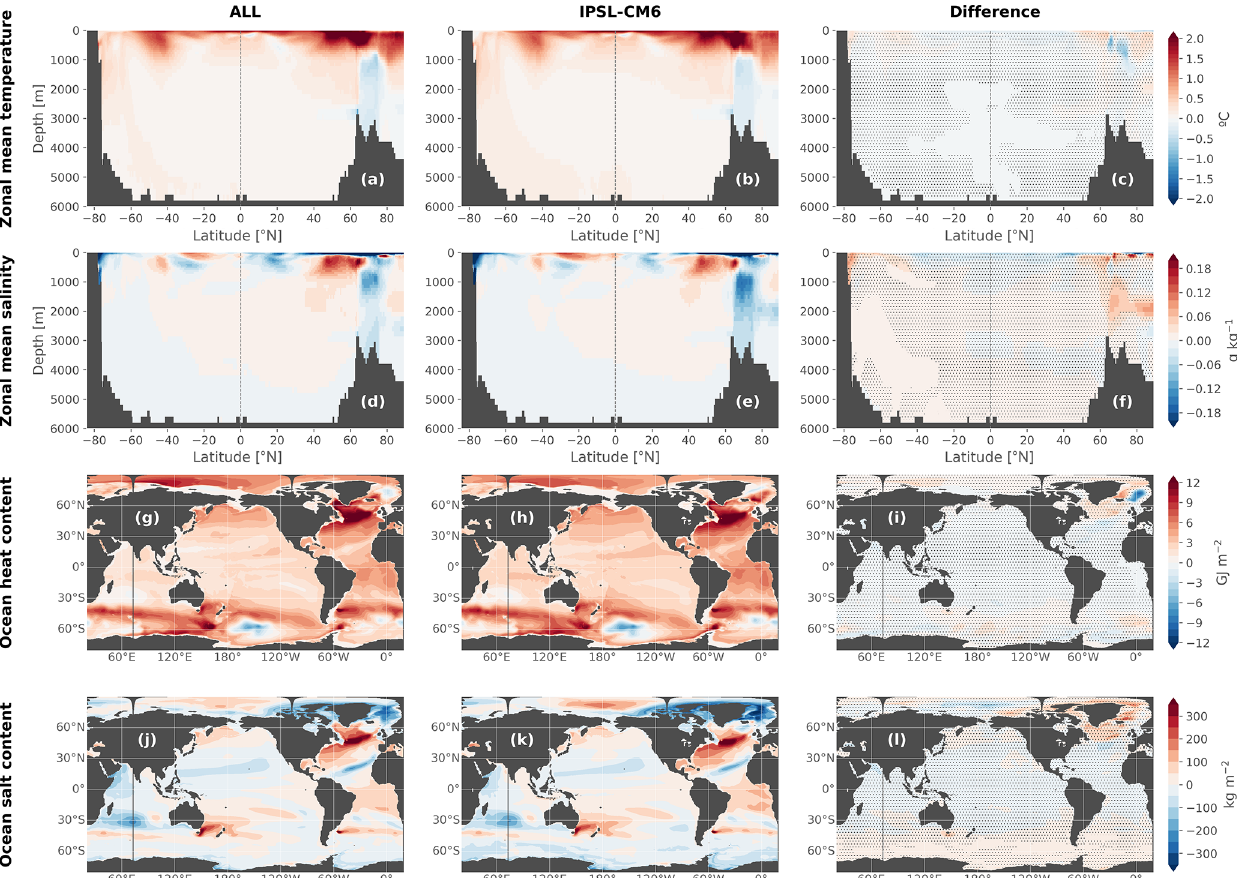
Figure 11. Annual-mean anomalies in zonal mean temperature (a–c) , zonal mean salinity (d–f) , vertically integrated ocean heat content (g–i) and ocean salt content (j–l) , averaged over 2040–2059 relative to 1850–1899. The anomalies are calculated for the forced response in the ALL experiment (i.e., the difference between ALL and CTL; left column) compared to the forced response in the IPSL-CM6A-LR model as calculated from the ensemble mean (middle column). The difference between the ocean-only forced response in ALL and the coupled model ensemble mean is represented in the third column; the stipples indicate where the difference is lower than twice the inter-member standard deviation. All the data have been corrected for ocean drift in this